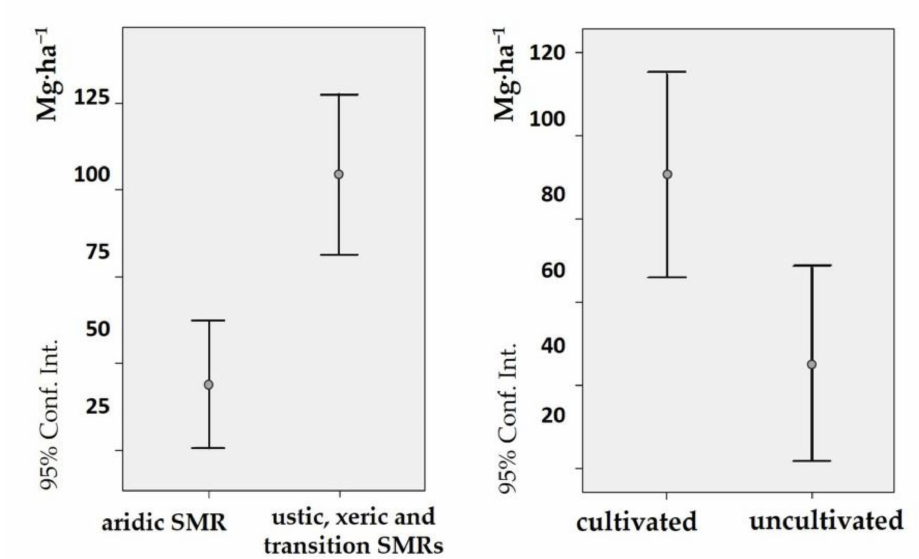
Figure 4. Statistical analysis of the differences in the values of SOC stock considering soil moisture regimes ( left ) and basic land use (95% confidence intervals). Software: IBM SPSS Statistics